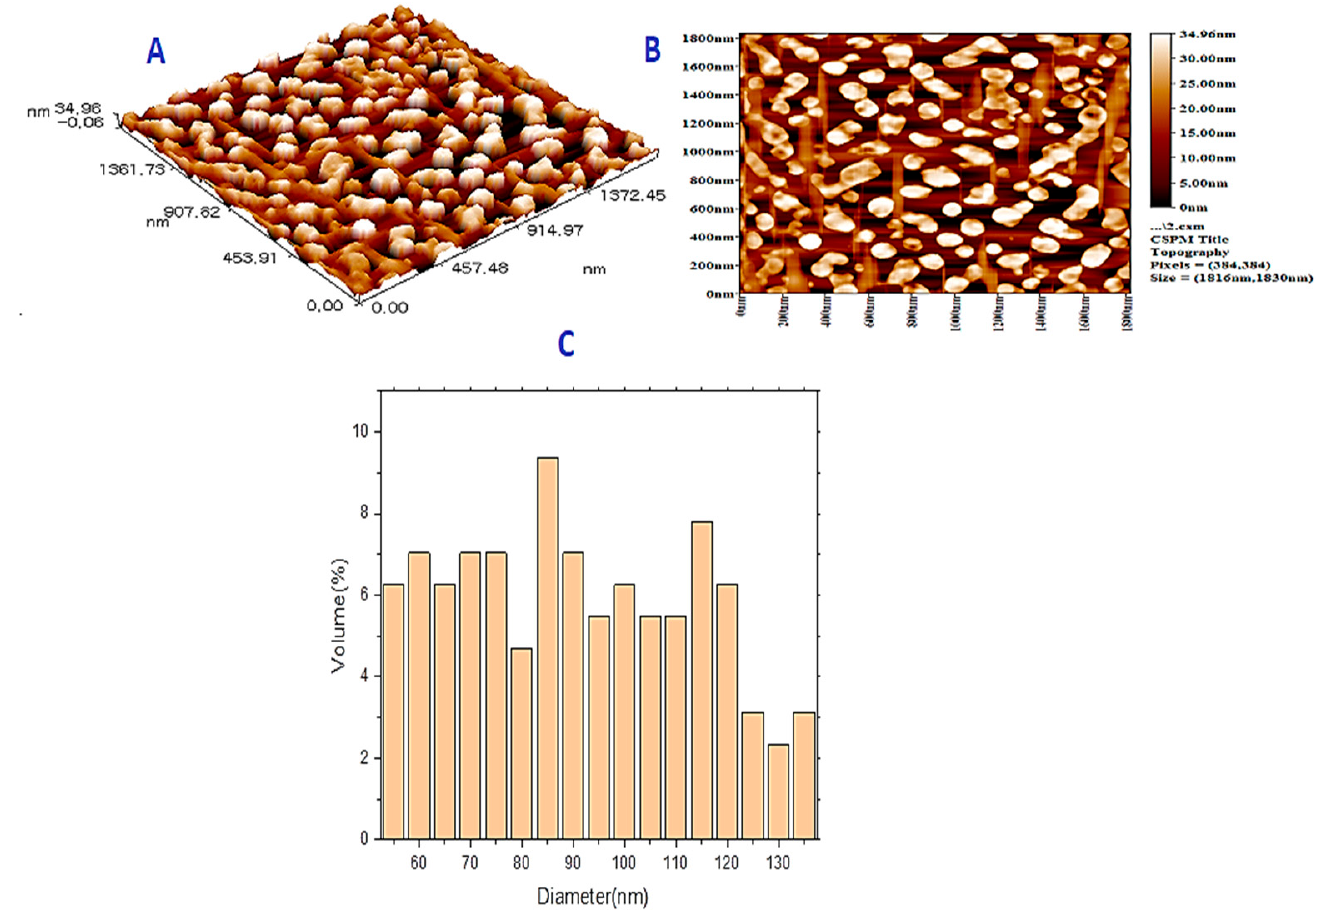
Figure 4. Images of Atomic Force Microscope for the PMG nanoparticles: ( A ) 3D and ( B ) 2D images. ( C ) Granularity cumulative distribution of the PMG NPs.